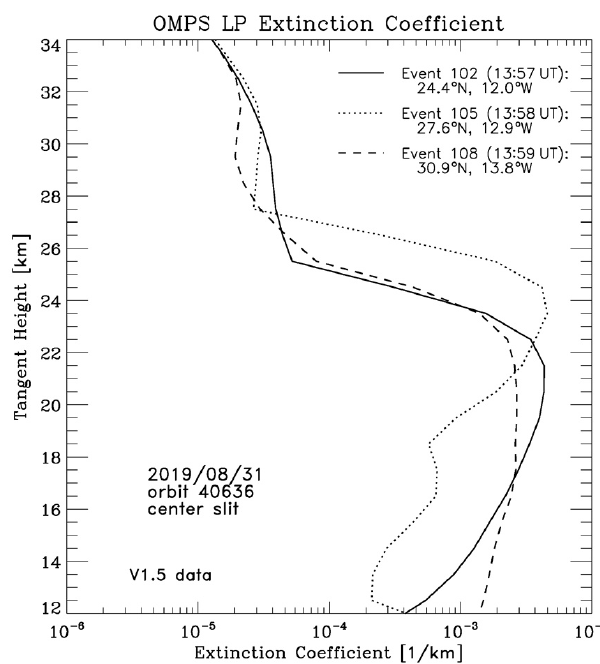
Figure 12. The aerosol formed as a result of the Raikoke eruption is clearly visible in the extinction coefficient profiles obtained by the OMPS LP aerosol extinction vertical profile months after the